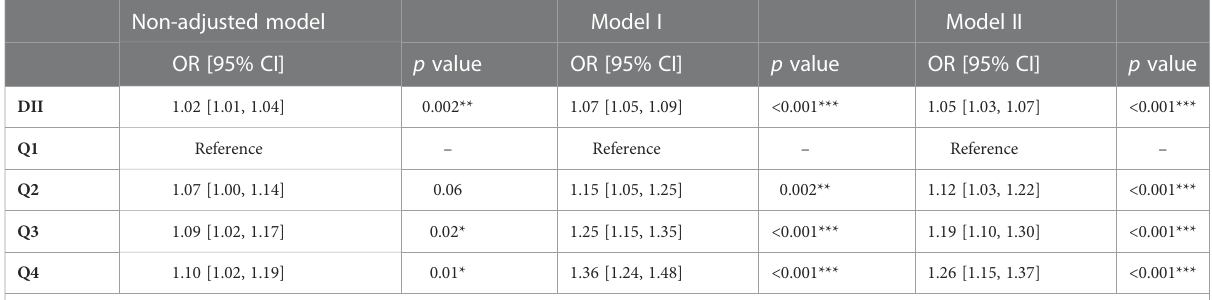
TABLE 3 Logistic regression analysis on the association between DII and